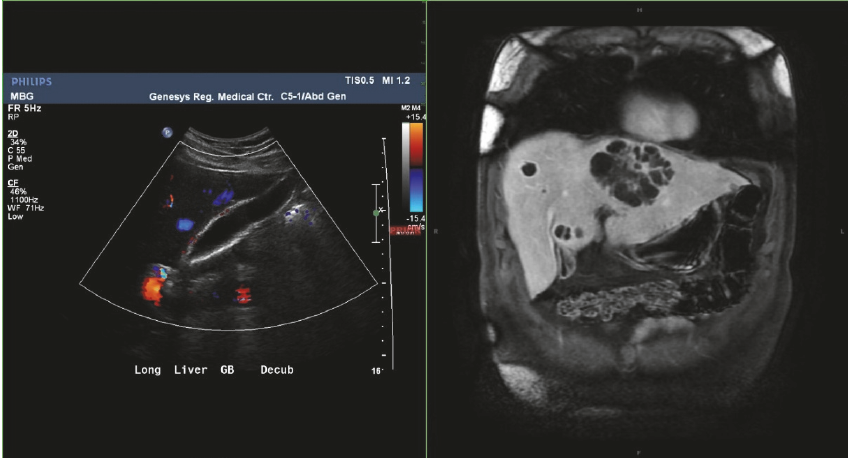
Figure 2: Long imaging showing initial negative ultrasound (left) and follow-up coronal MRCP showing liver abscesses (right).